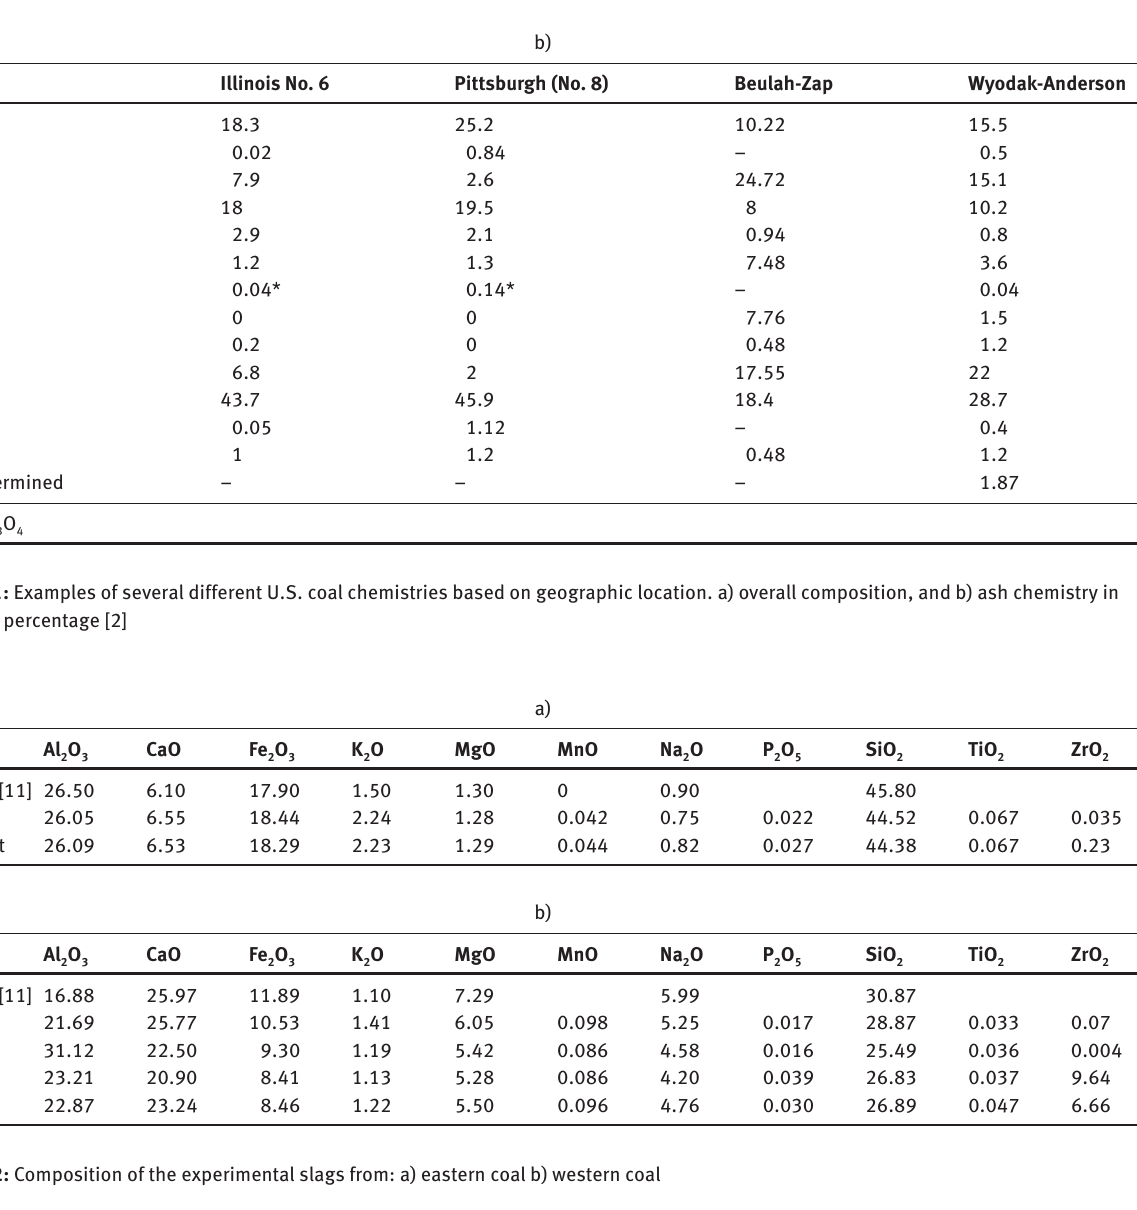
Table 2: Composition of the experimental slags from: a) eastern coal b) western